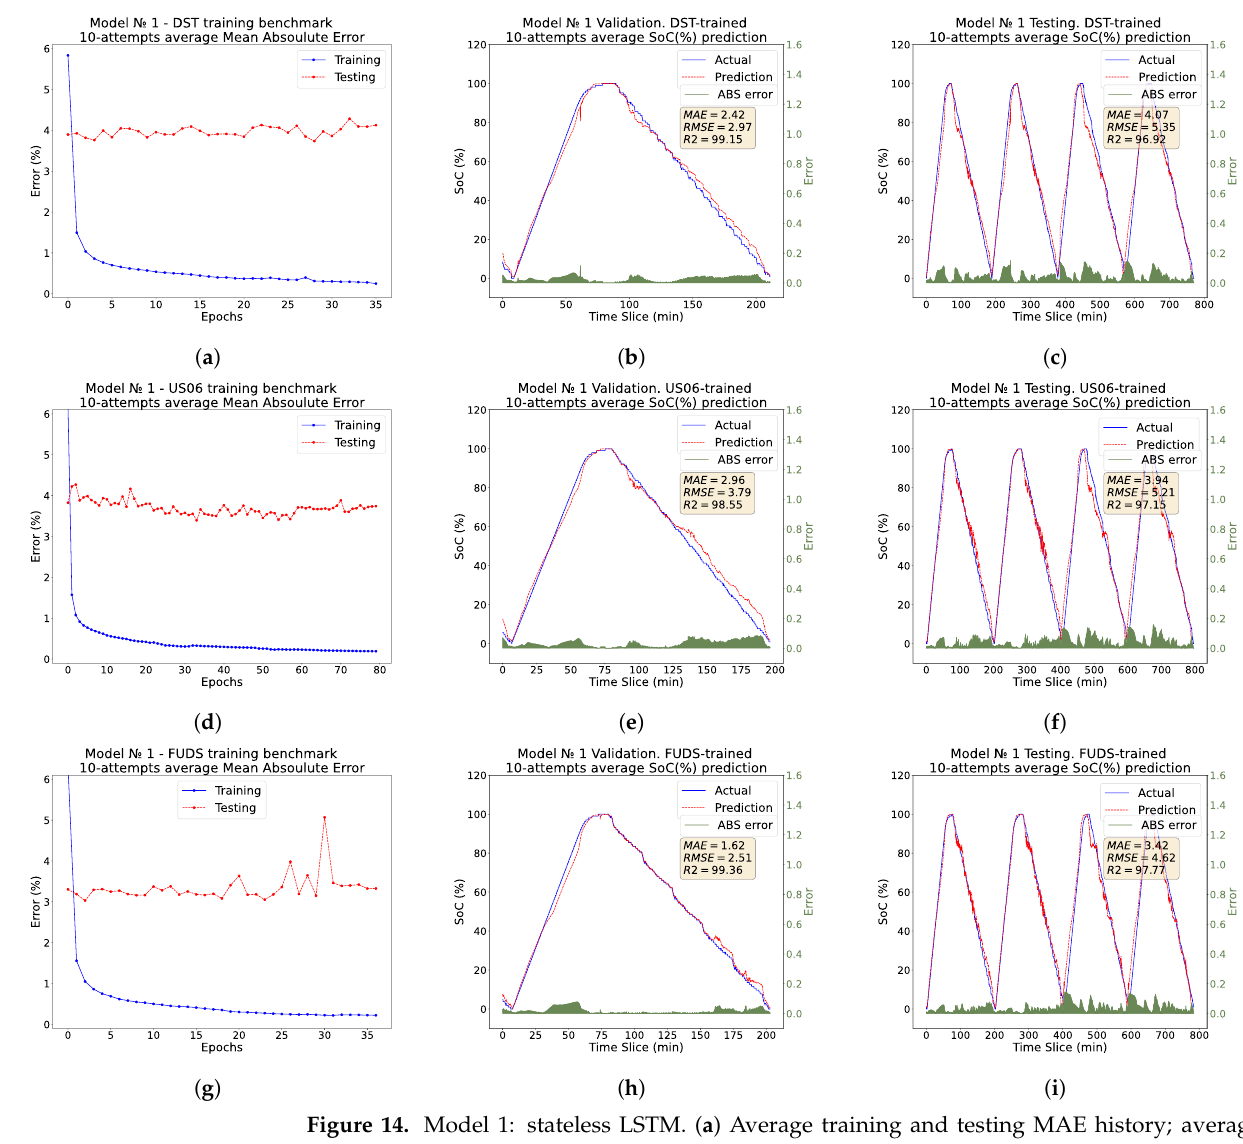
Figure 14. Model 1: stateless LSTM. ( a ) Average training and testing MAE history; average of 10 attempts. ( b ) Validation on a single cycle of SoC estimation; average of 10 attempts at 25 °C. ( c ) Testing on two cycles of US06 and FUDS profiles; average of 10 attempts. ( d ) Average training and testing MAE history; average of 10 attempts. ( e ) Validation on a single cycle of SoC estimation; average of 10 attempts at 25 °C. ( f ) Testing on two cycles of US06 and FUDS profiles; average of 10 attempts. ( g ) Average training and testing MAE history; average of 10 attempts. ( h ) Validation on a single cycle of SoC estimation; average of 10 attempts at 25 °C. ( i ) Testing on two cycles of DST and US06 profiles; average of 10